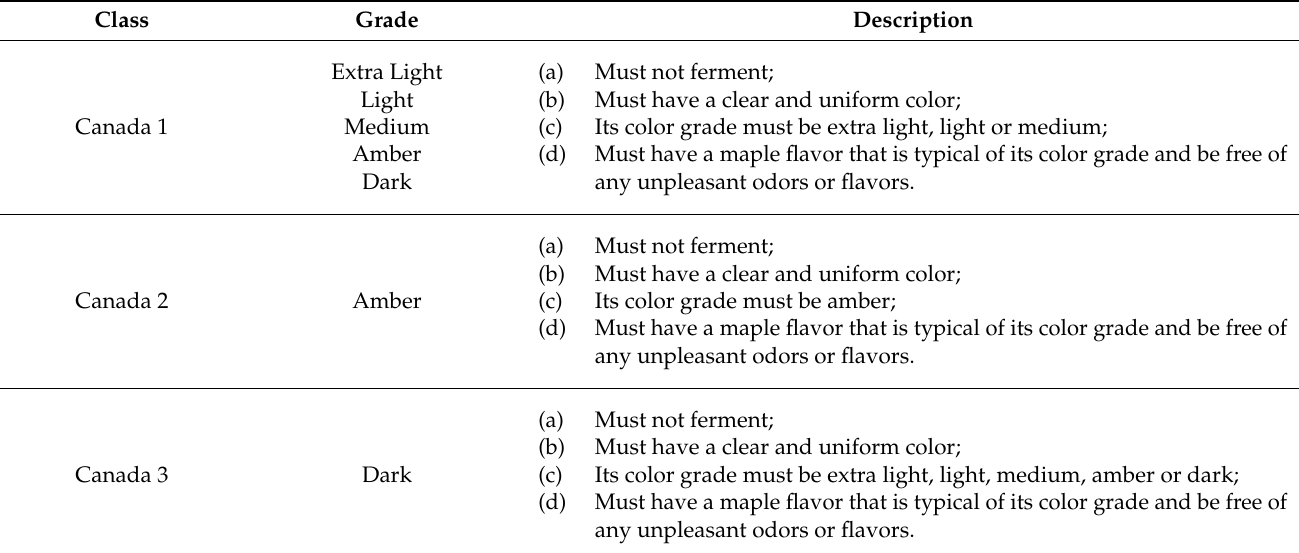
Table 4. Canadian federal classification of maple syrup [51].